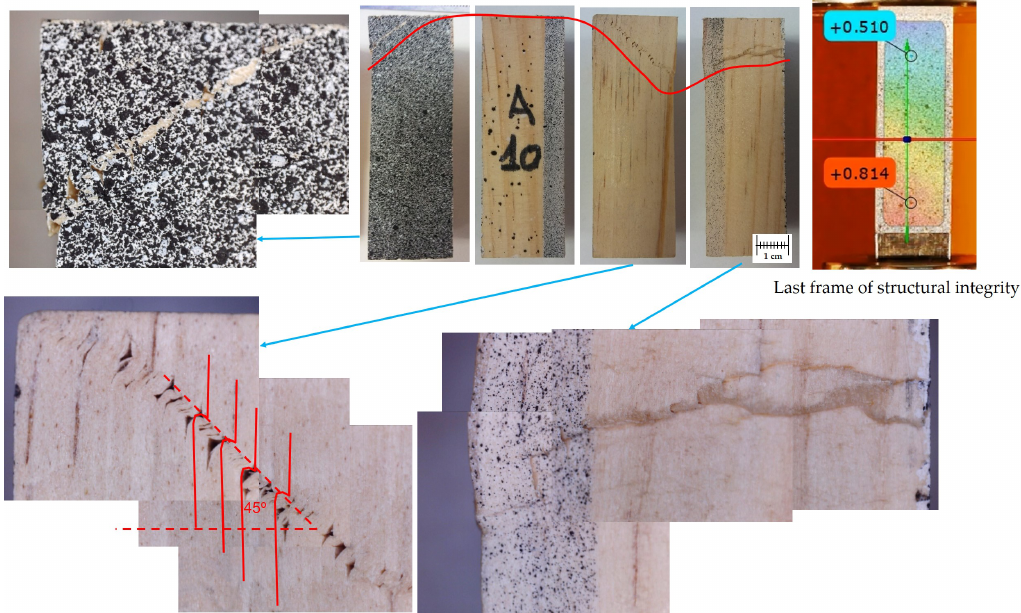
Figure 20. Appearance of the damage produced in the specimen A10. Comparison with the last frame of the structural integrity of the sample.